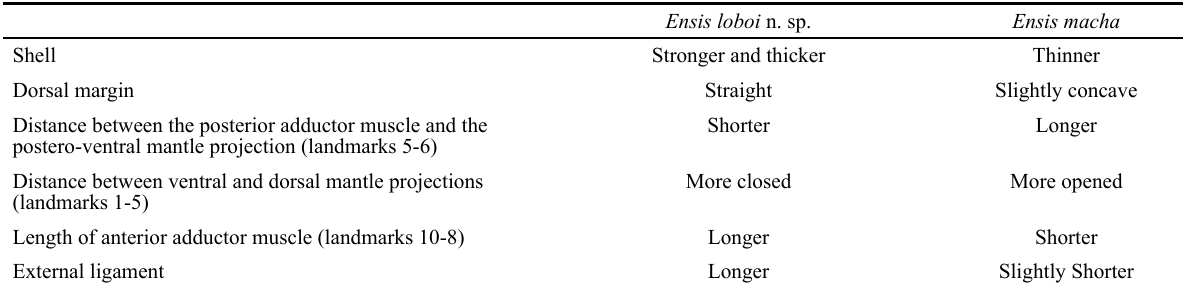
Fig. 4. – Type material of Ensis loboi n. sp. A-D: holotype, CNP-Inv 875. E-J: paratypes, CNP-Inv 281. K-N: paratypes CNP-Inv 844. O-R: paratypes, CNP-Inv 874. Scale bar 5-8, 11-14=2 cm; 9-10=5 mm; 15-22=3 cm.